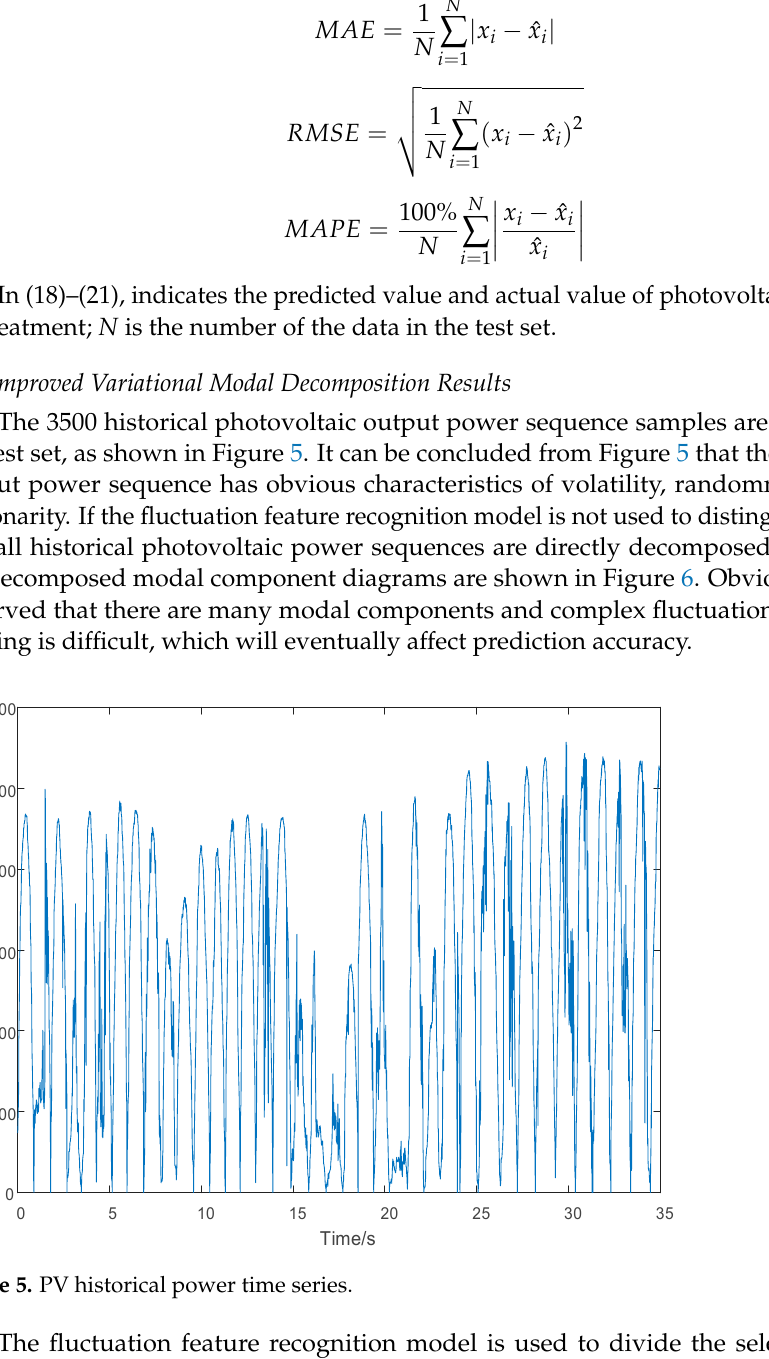
Figure 6. Improved VMD decomposition results of all samples.